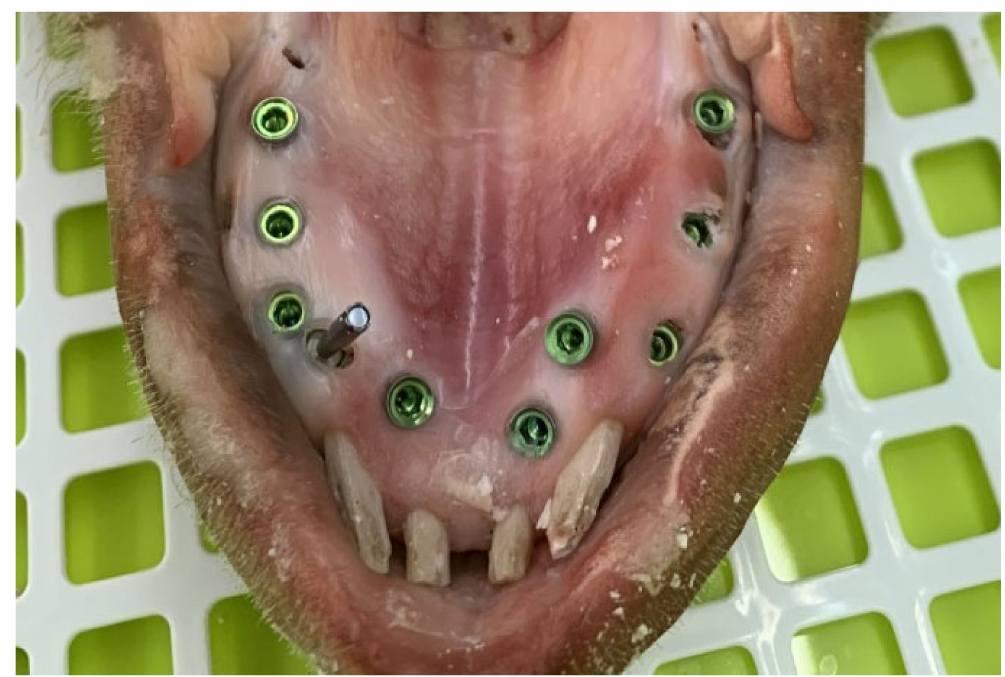
Figure 1. Implant locations in a representative mandible with a Penguin ® multipeg inserted in one of the